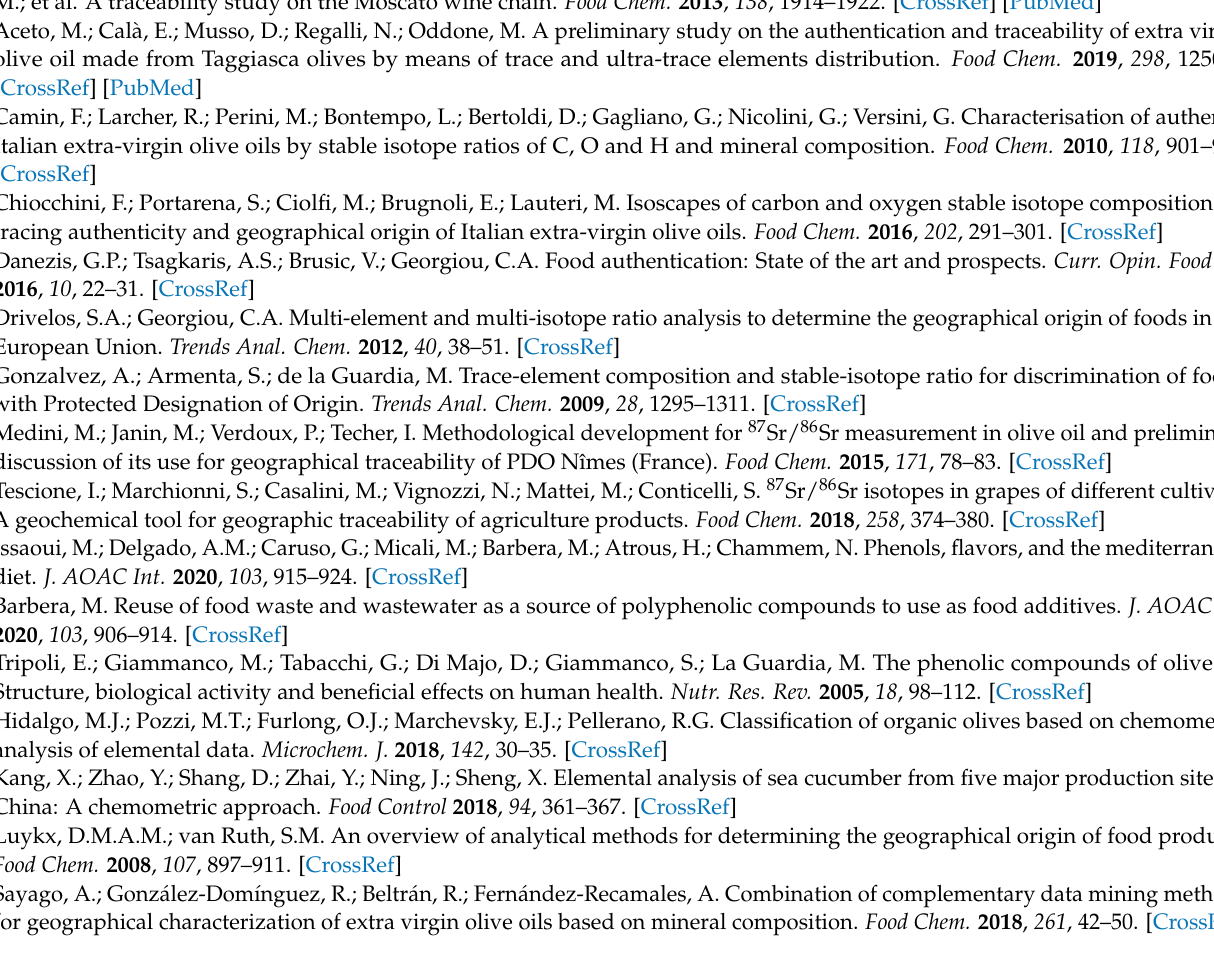
Figure S1. UCC-normalised REE pattern of all Campo Carboj olive